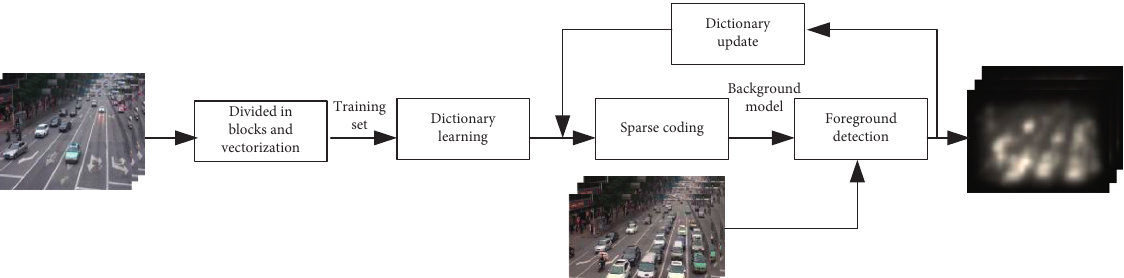
Figure 1: Overview of the proposed